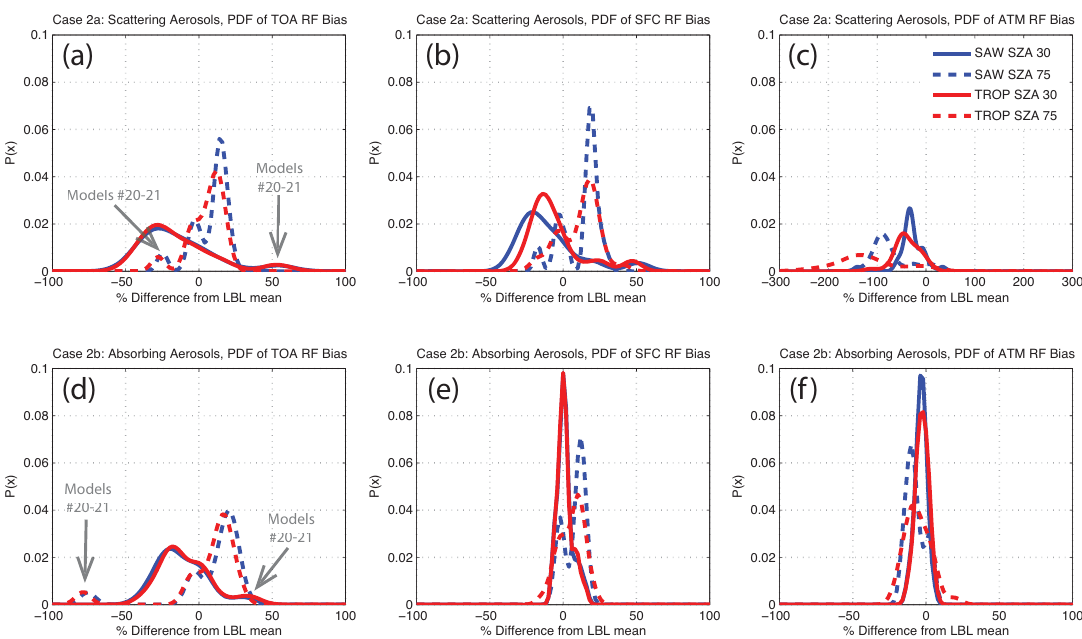
Fig. 7. For each solar zenith angle and prescribed atmosphere combination, the probability density function P(x) for (a) scattering aerosol (Case 2a) TOA RF bias, (b) scattering aerosol (Case 2a) SFC RF bias, (c) scattering aerosol (Case 2a) ATM RF bias, (d) absorbing aerosol (Case 2b) TOA RF bias, (e) absorbing aerosol (Case 2b) SFC RF bias, and (f) absorbing aerosol (Case 2b) ATM RF bias. Biases are calculated as the percent deviation of each non-LBL model from the LBL mean: Bias=100 × µ model where µ is the mean. Negative biases imply too much radiative cooling or too little radiative warming; positive biases imply too little radiative cooling (too much radiative warming). The small peaks in the PDF are from Models #20 and 21 which use the Eddington approximation (as opposed to the δ -Eddington approximate used in the counterpart Models #22 and 23).